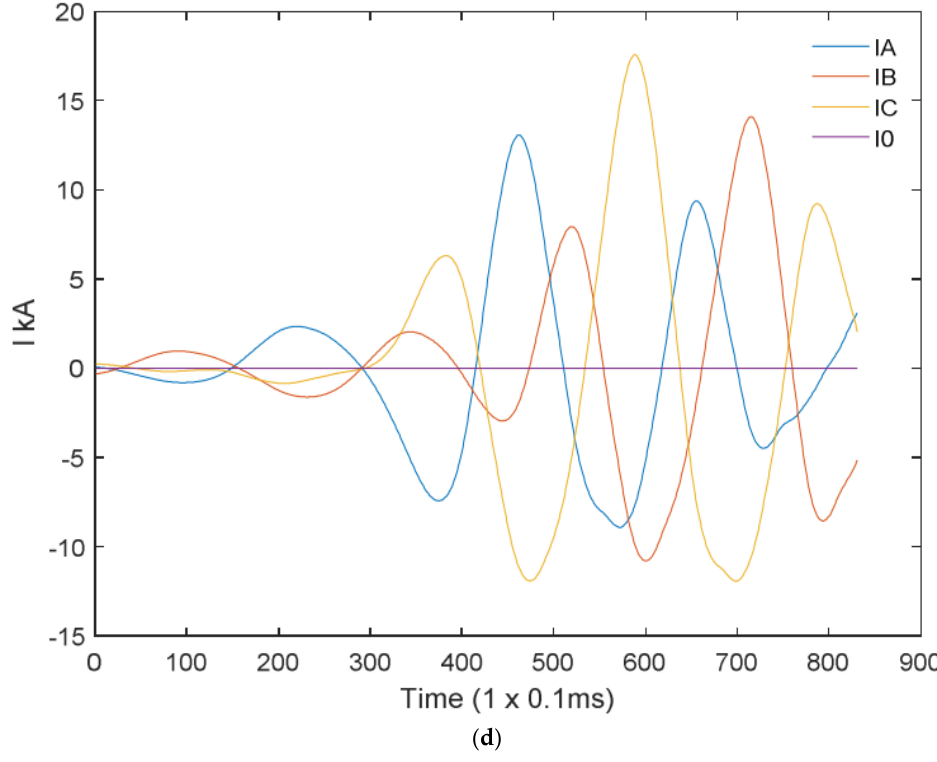
Figure 7. LG ( a ), LL ( b ), LLG ( c ), and LLLG ( d ) fault current signals.